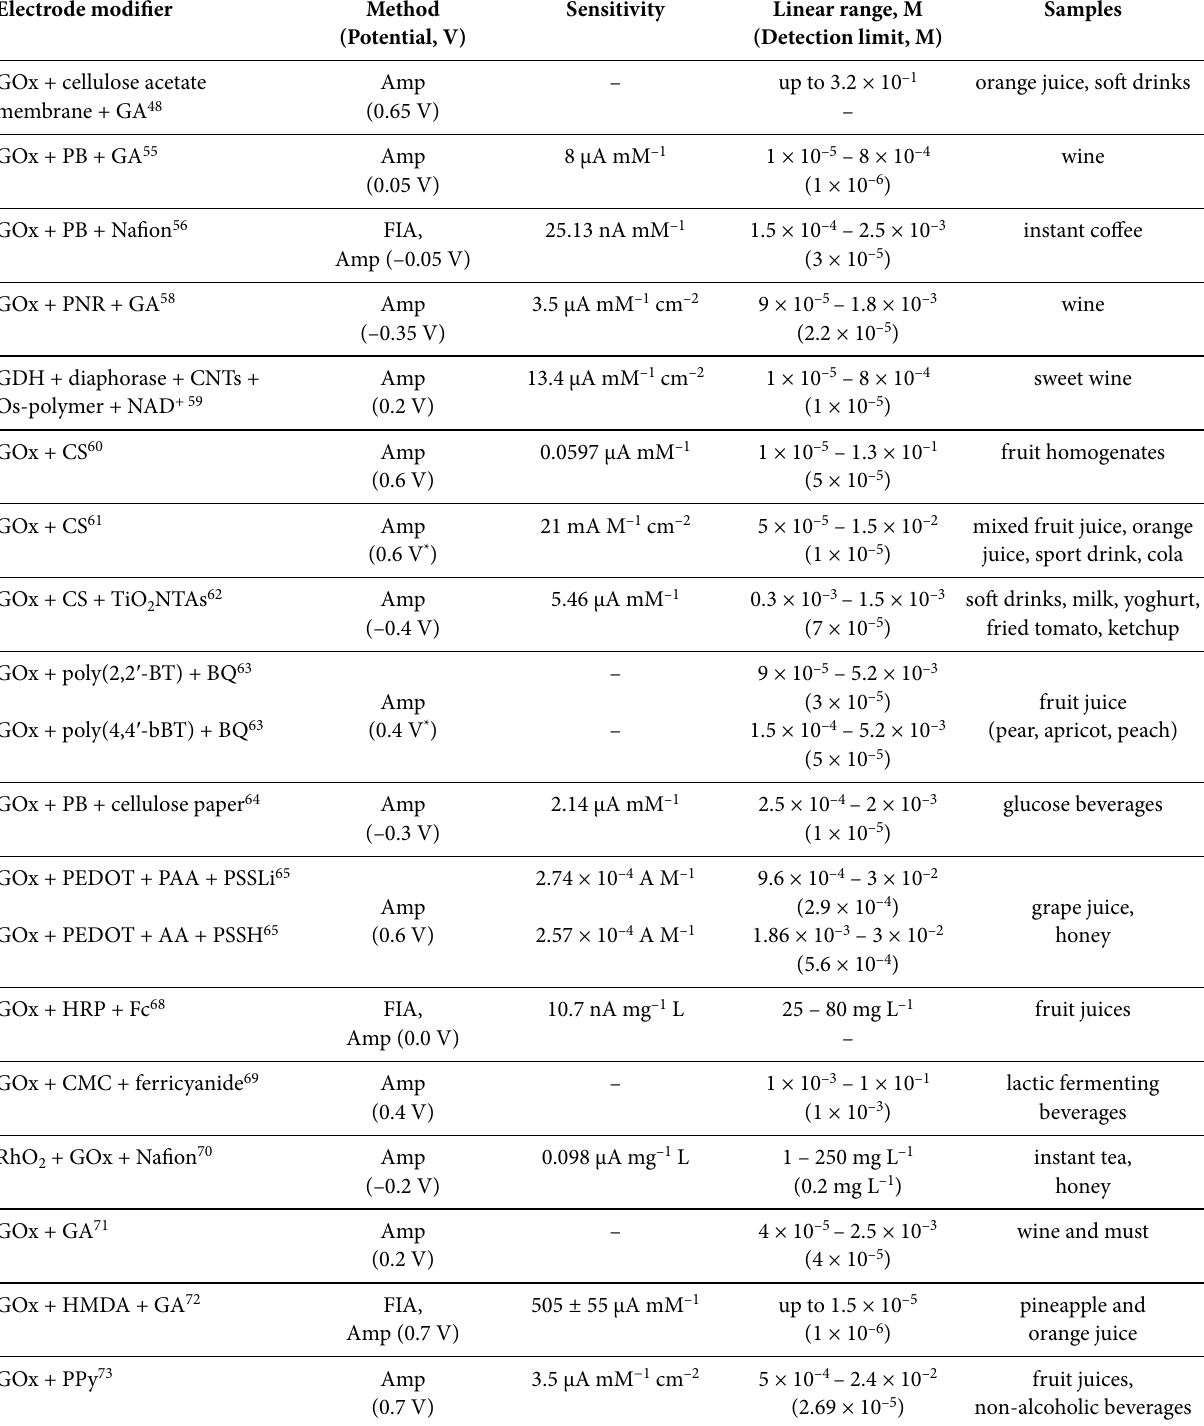
Table 1. Electrochemical biosensors for glucose analysis in food